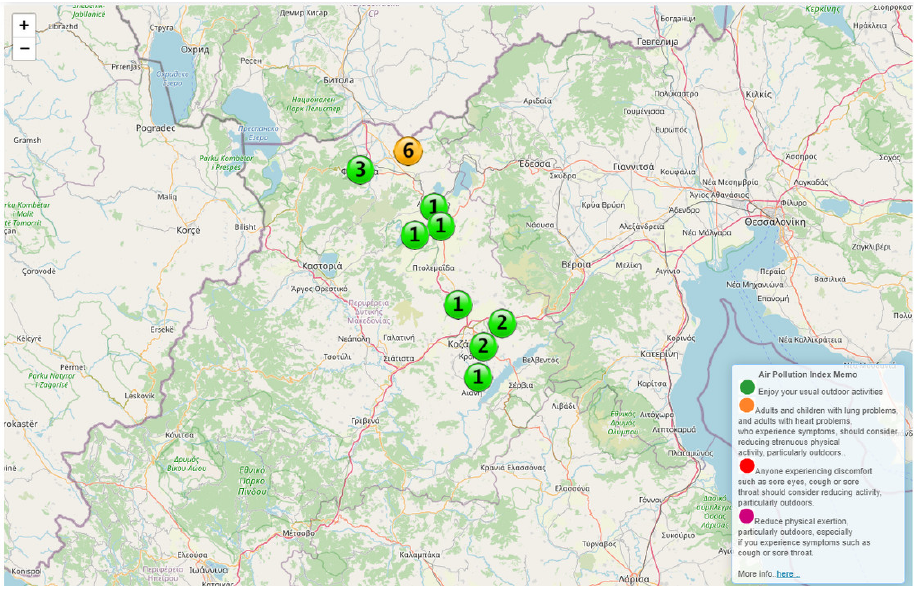
Figure 3. Air quality map (values and color in the circle correspond the DAQI).